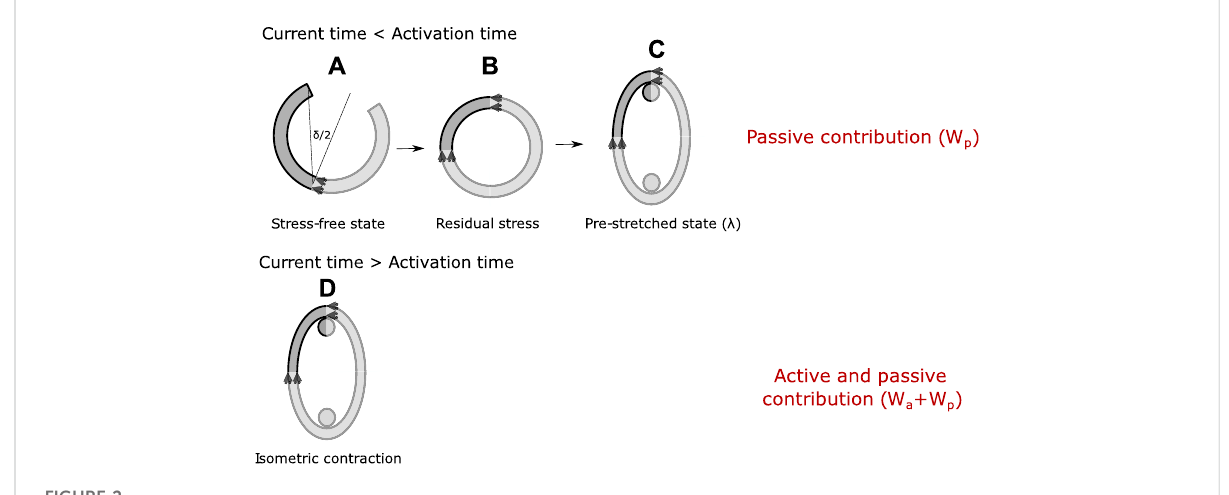
Numerical procedure followed in the simulation of the isometric contraction test. The dark-gray shaded areas represent the geometry considered for the simulation. Symmetry along thickness was considered in all cases, with the corresponding boundary condition.